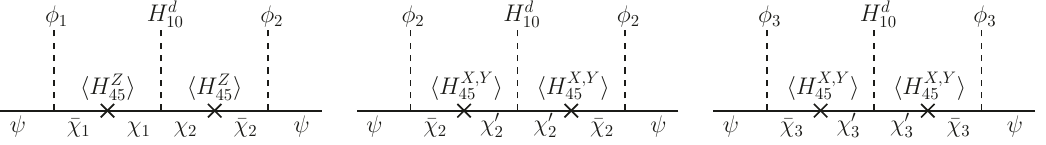
Figure 2 . Diagrams